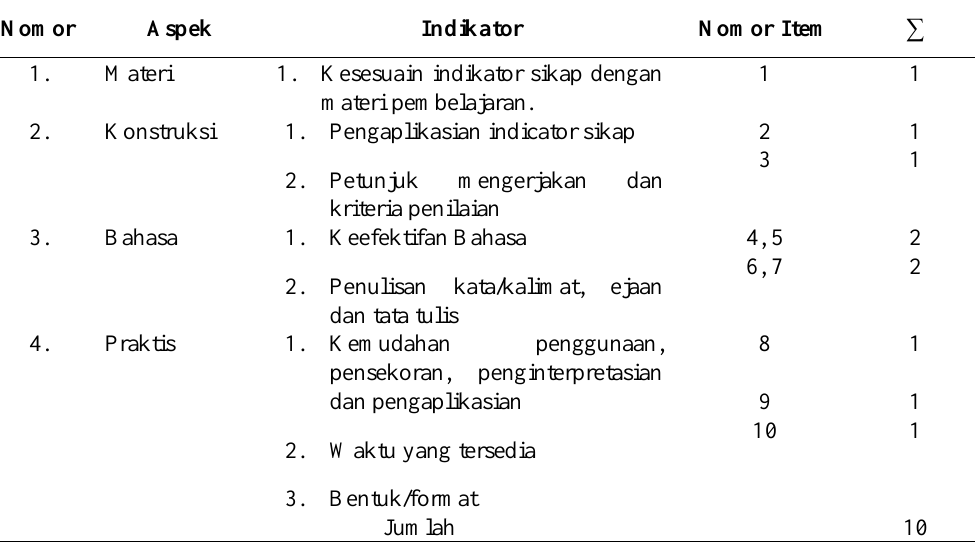
Tabel 1 . Kisi-kisi Penilaian